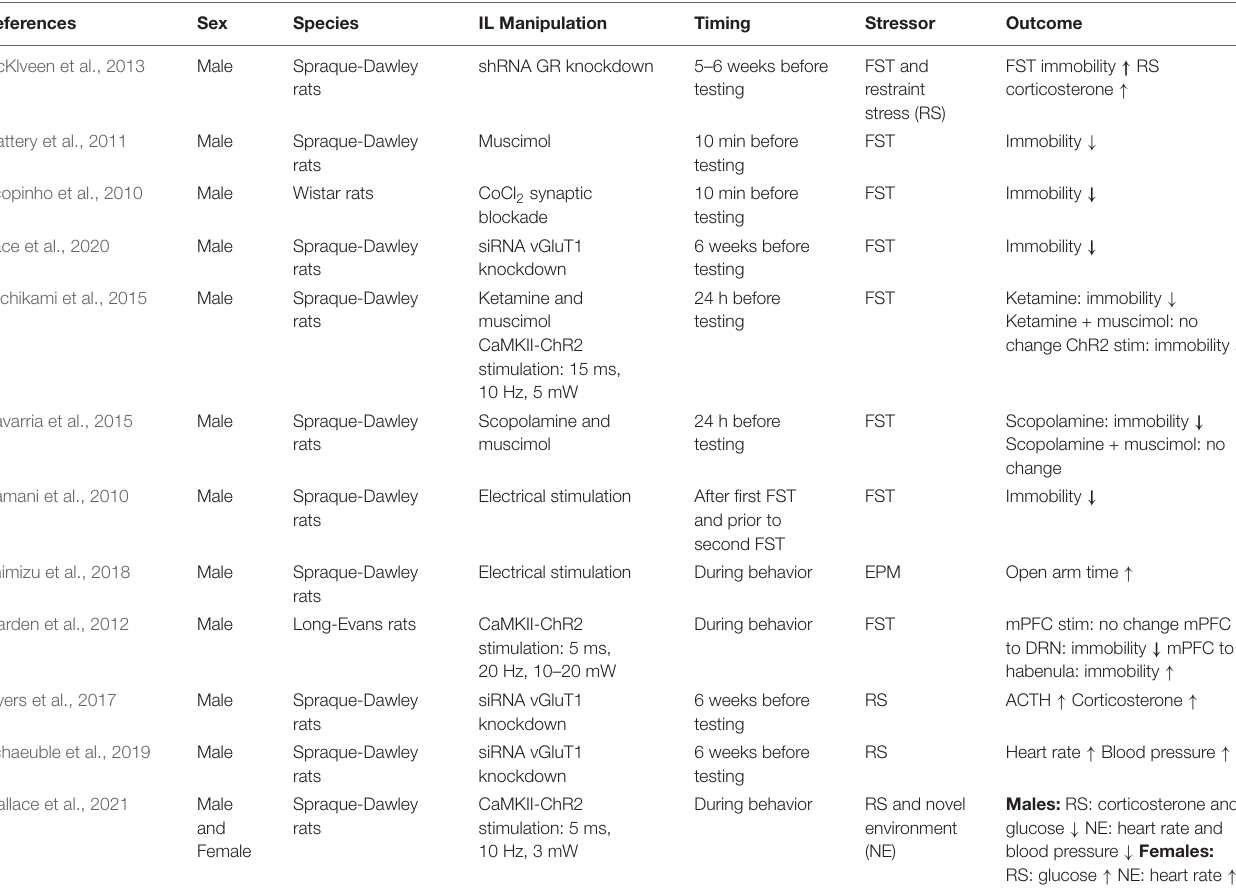
TABLE 1 | Negatively valenced stimuli.